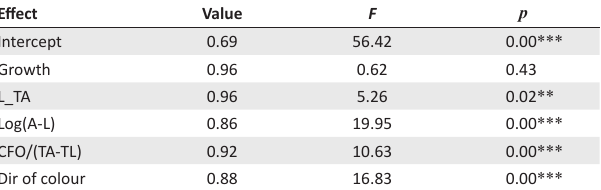
TABLE 6: Results of the general discriminant analysis.